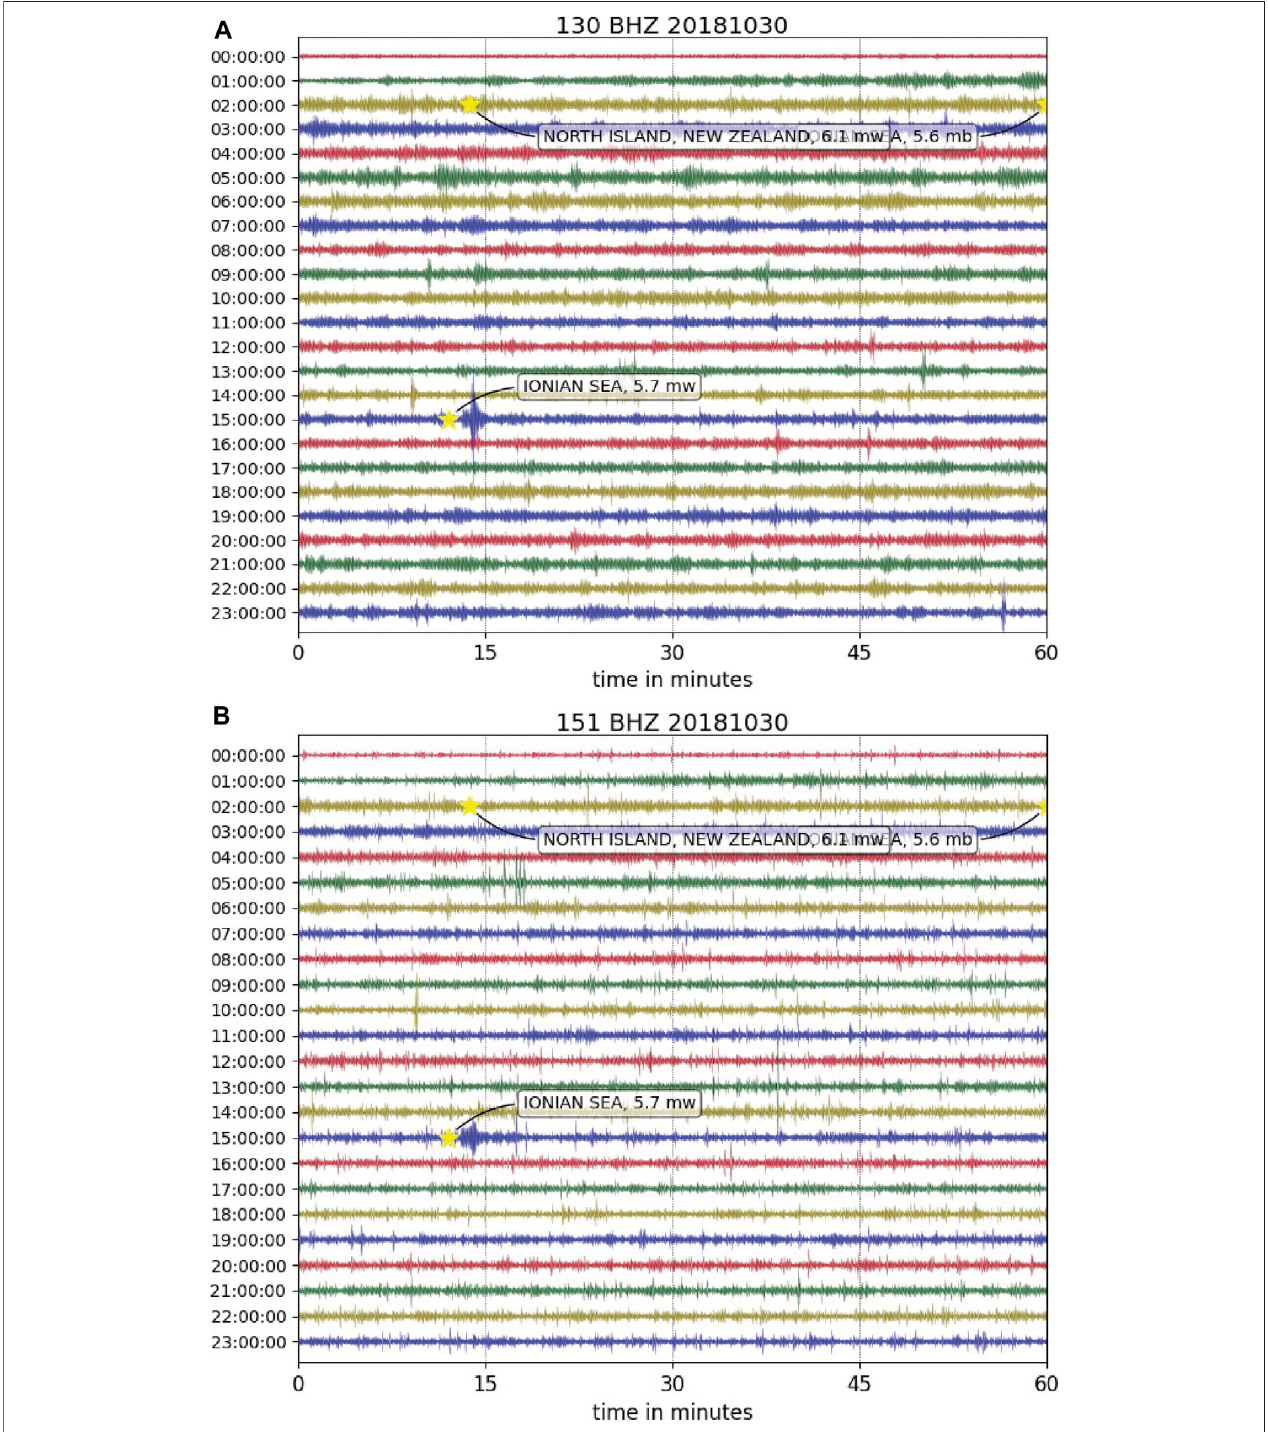
FIGURE 2 | Day-plots for 30 October, 2018 showing the vertical component of stations 130 (top) and 151 (bottom). P-arrivals of the teleseismic events with magnitude larger than 5.5 that occurred on the same day are also indicated with the yellow stars. Node locations are shown in Figure 1C .